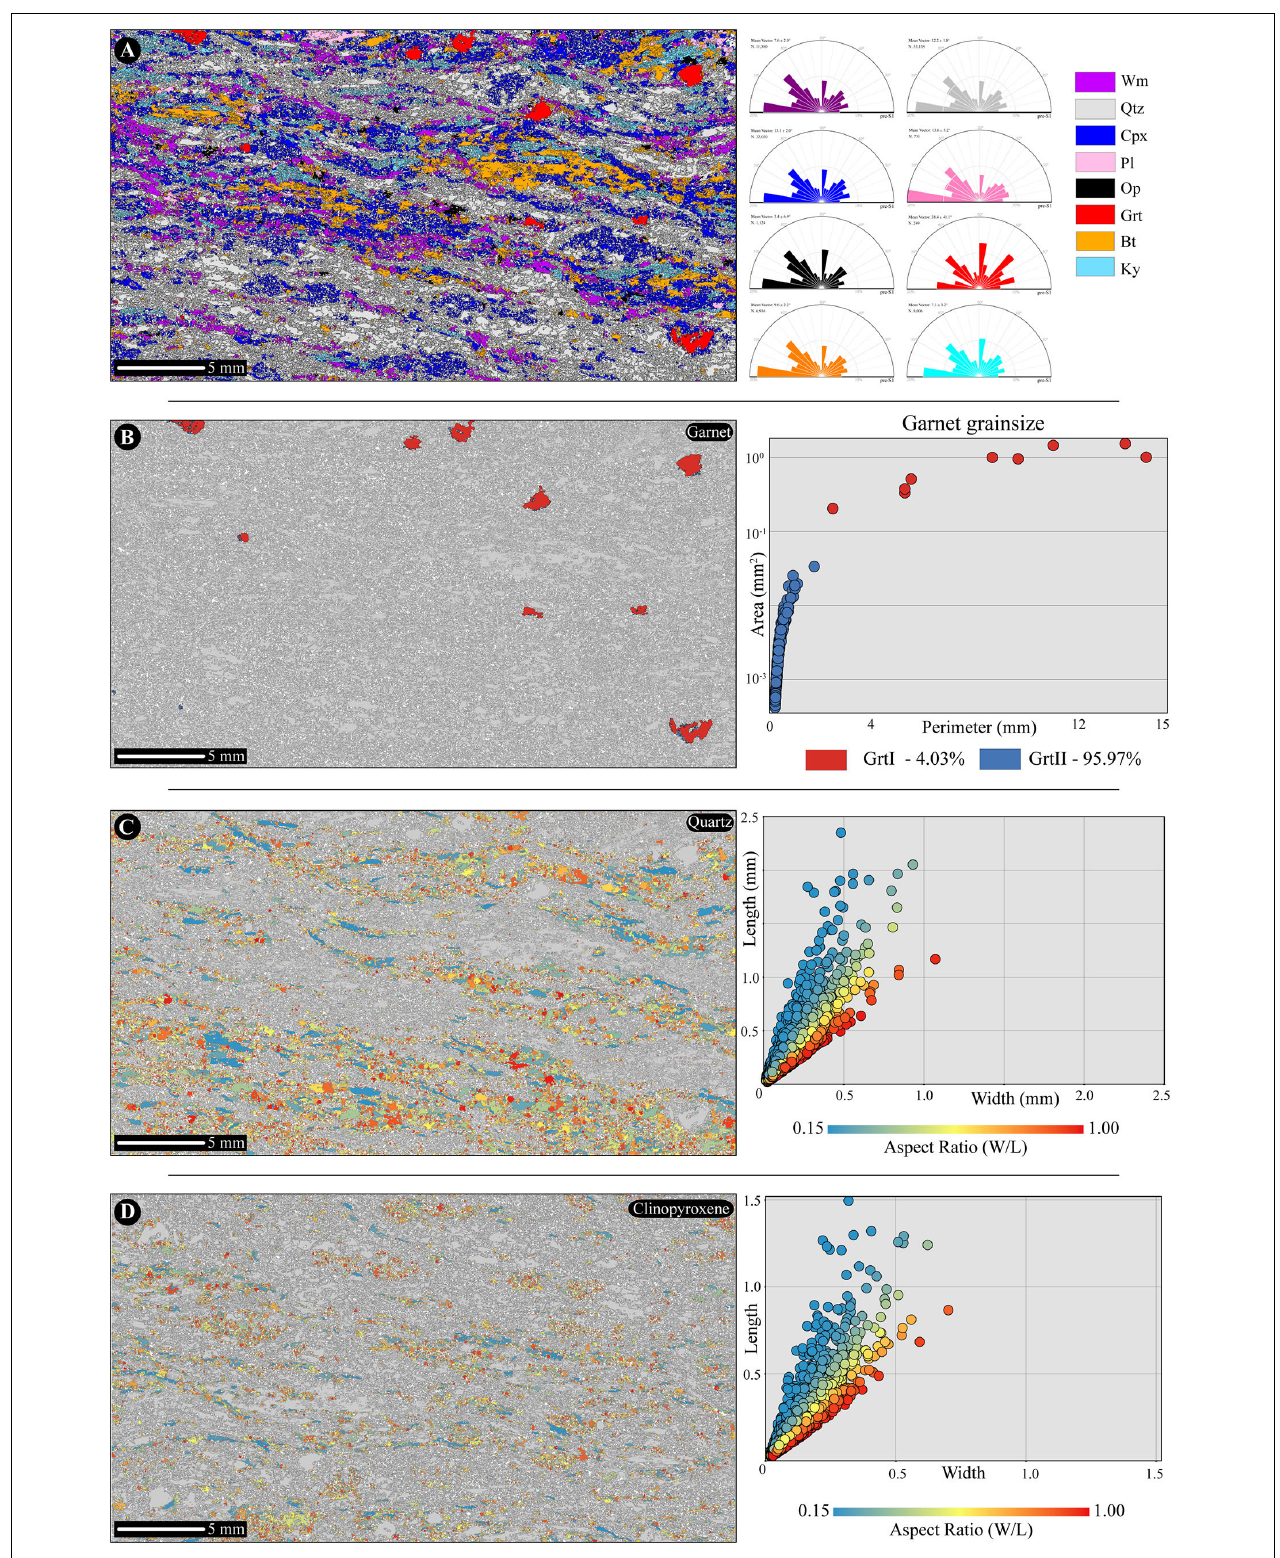
FIGURE 5 | (A) Results of Min-GSD and grains orientation with respect to pre-S1 foliation for each mineral phase. (B) Garnet grainsize map and grainsize vs. perimeter plot. (C) Aspect Ratio map of Qtz and Length vs. Width plot for all Qtz grains. (D) Aspect Ratio map of Cpx and Length vs. Width plot for all Cpx grains.